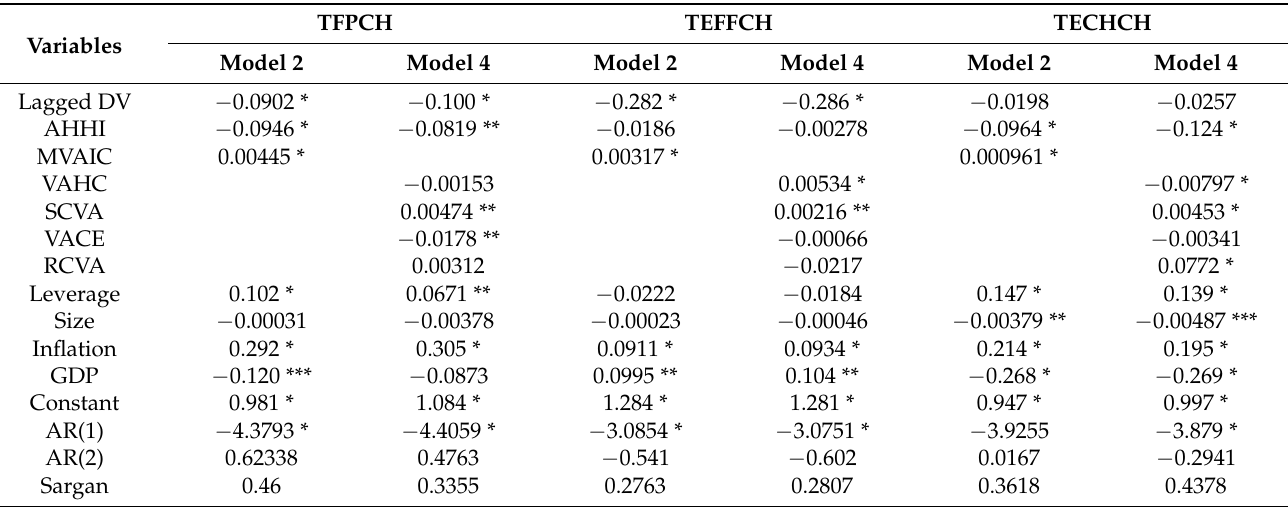
Table 5. Productivity—Intellectual Capital Nexus